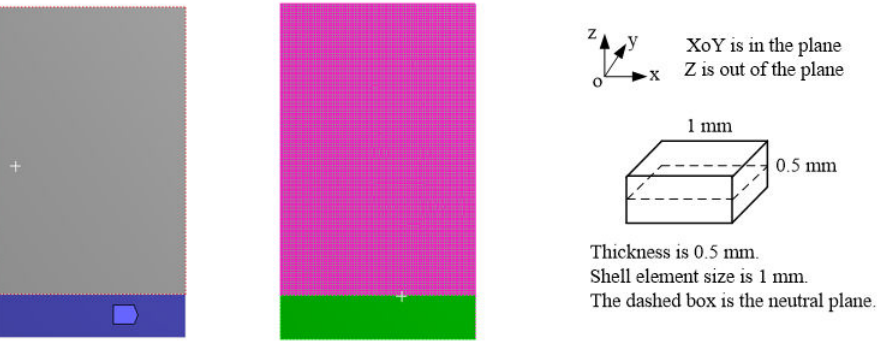
Figure 9. FE model of this thin blade and the schematic of one shell